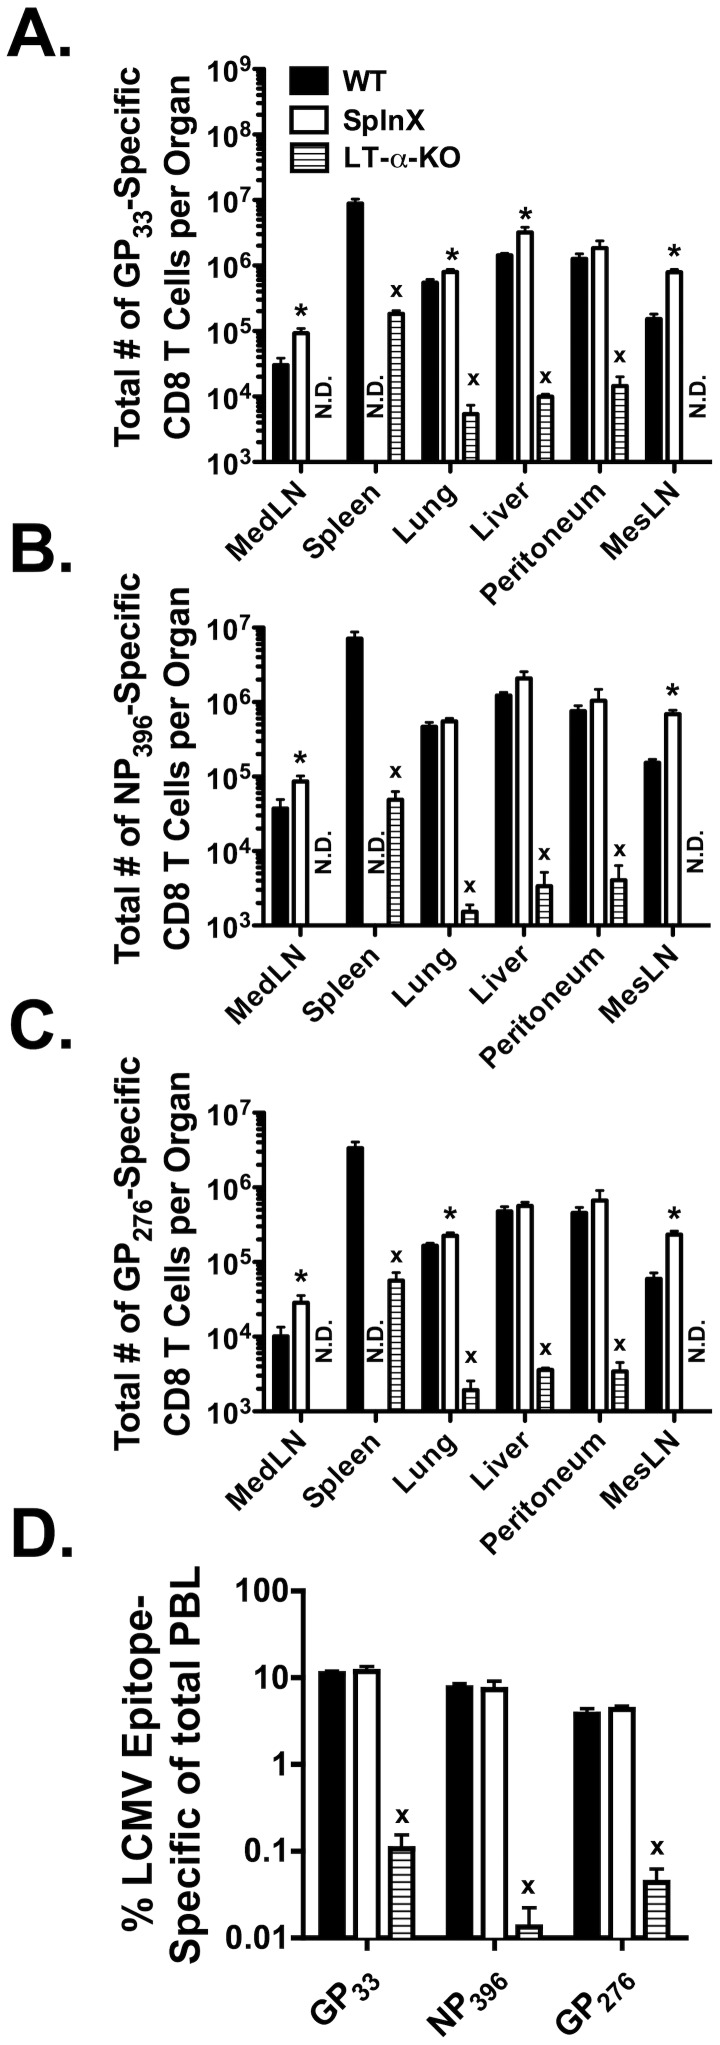
LT-α-KO mice exhibit a dramatically reduced LCMV-specific CD8 T cell response.WT, LT-α-KO and splenectomized mice were infected with LCMV i.p.. The LCMV (A) GP33-, (B) NP396- and (C) GP276-specific CD8 T cell responses from the indicated tissues were measured at day 8 post-LCMV infection via ICS for IFN-γ. (D) GP33-, NP396- and GP276-specific CD8 T cell responses in the peripheral blood. *, significantly greater (p<0.05) than WT control mice as determined by Student t-test. x, significantly decreased (p<0.05) as compared to WT control mice as determined by Student t-test. Representative data from one of three individual experiments with 3–5 mice per group per experiment. Error bars represent the standard error of the mean. N.D. = none detected.